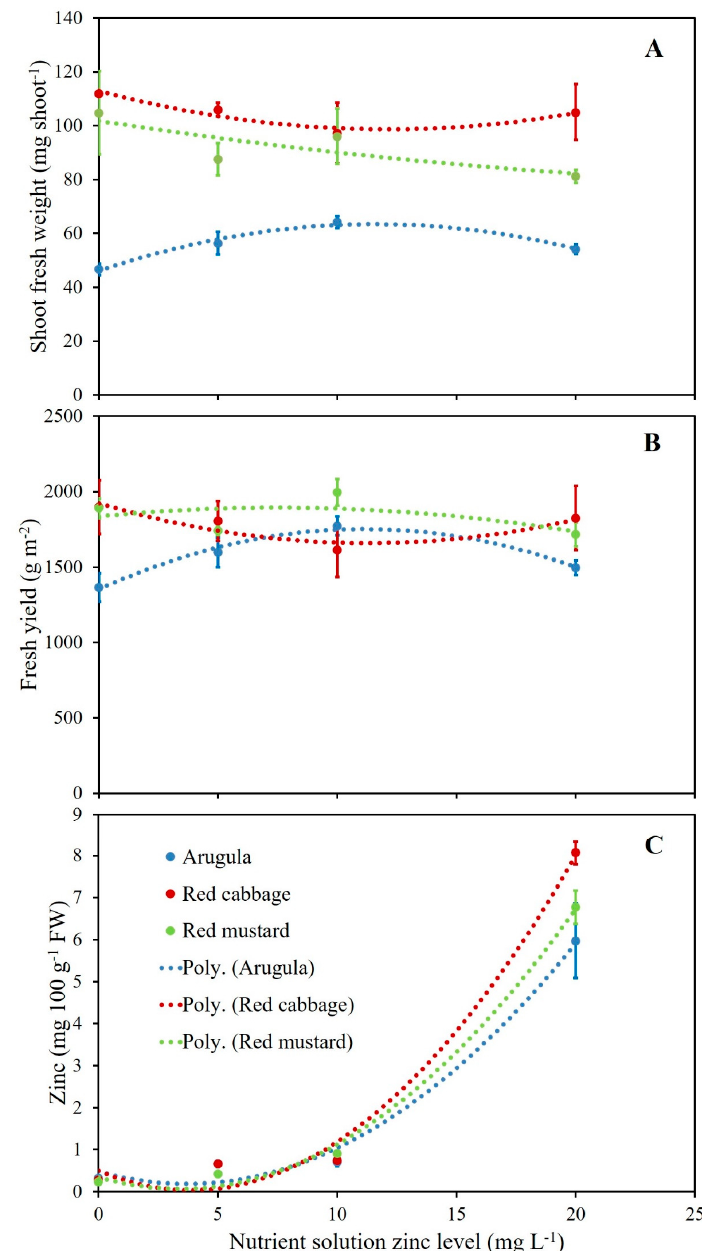
Figure 1. Relationship between single shoot fresh weight ( A ), fresh yield ( B ), zinc plant tissue concentration ( C ) and nutrient solution zinc concentration for arugula, red cabbage, and red mustard. Equations and coe ffi cient of determination ( R 2 ) are reported in Table